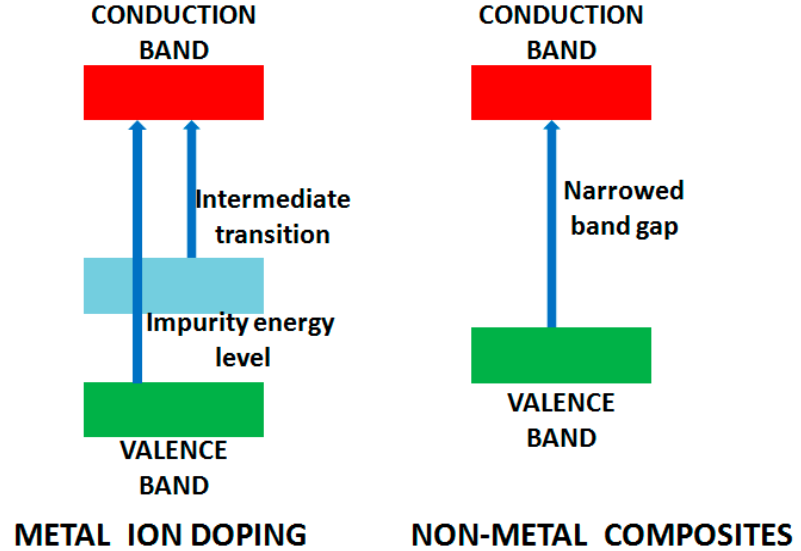
Figure 4. Modification of band gaps on metal ion doping and for non-metal composite.